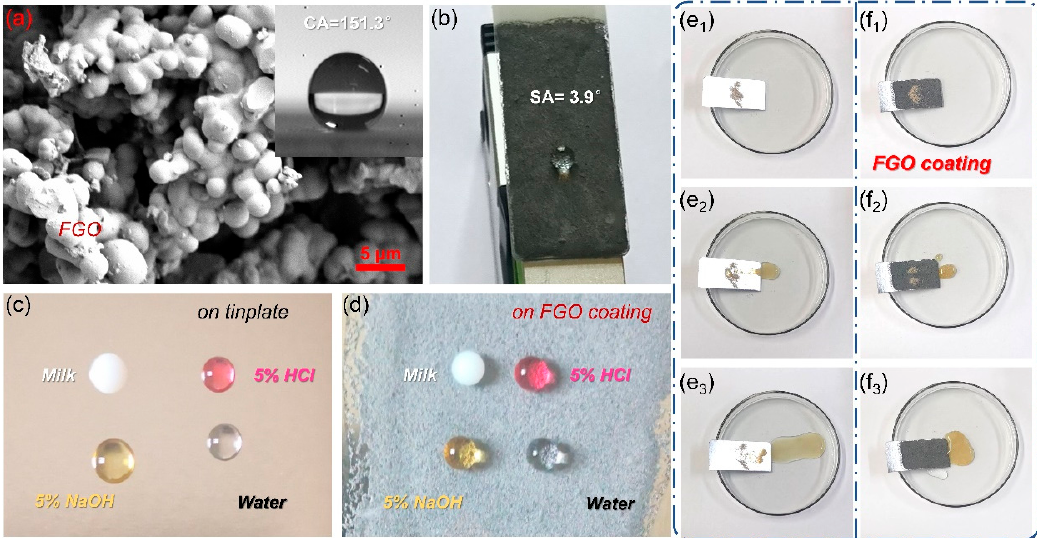
Figure 4. ( a ) State diagram of rolling angle and ( b ) water contact angle of FGO coating. Performance diagram of different liquid drops on the ( c ) tinplate and ( d ) FGO coating and self-cleaning diagram of the ( e1 – e3 ) tinplate and ( f1 – f3 ) FGO coating.